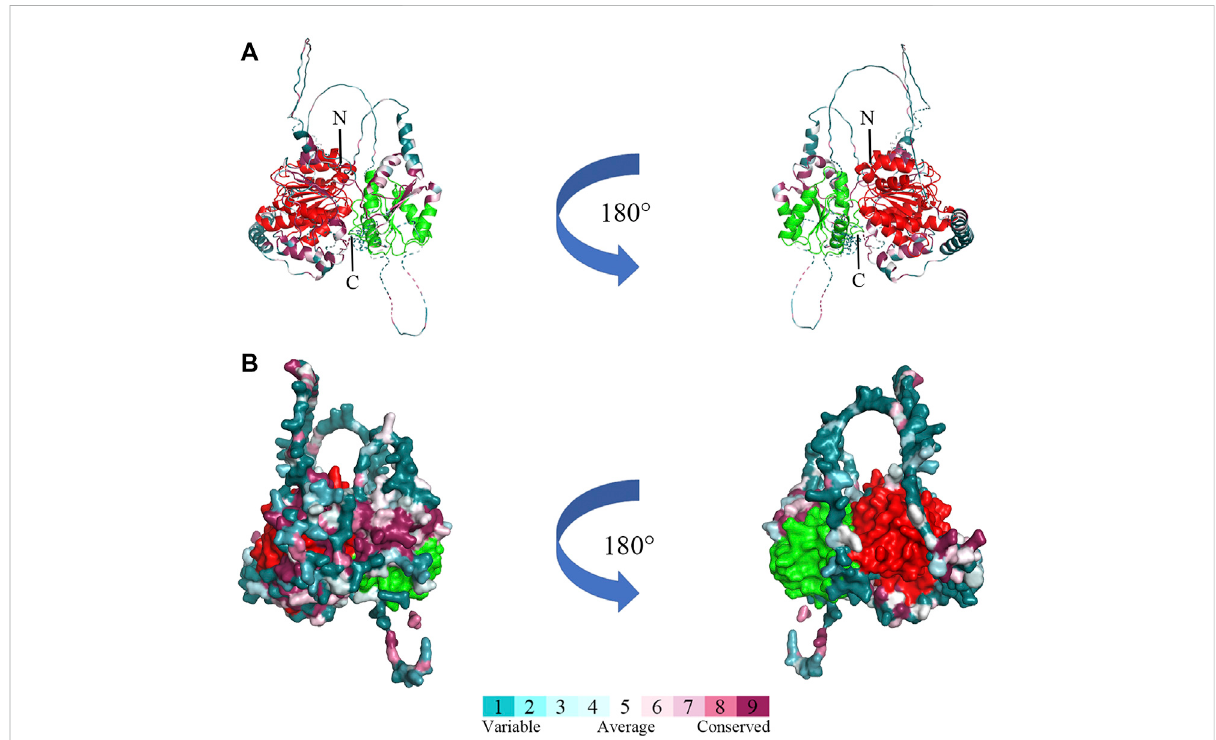
FIGURE 3 Predicted three-dimensional structure of Bxy-laf-1 . (A) Cartoon representative of Bxy-LAF-1. N, N-terminal; C, C-terminal. (B) The Bxy-LAF- 1 protein in surface representation. The right model is rotated along the long axis from the left model. The coloring gradient ranges from variable region to conserved regions, and the two conserved DNA-binding motifs are colored by red and green. The red area is DEAD box helicase, and the green is Helicase conserved C-terminal